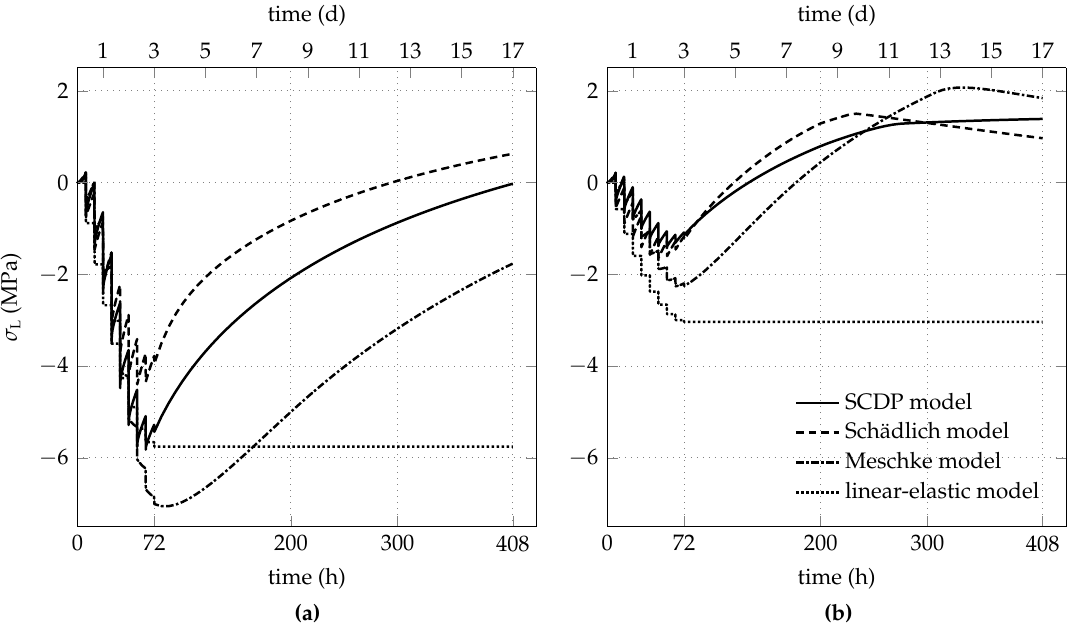
Figure 8. Predicted evolution of the longitudinal stress in the shotcrete shell for initial stress release ratios of ( a ) 85% and ( b ) 95%.